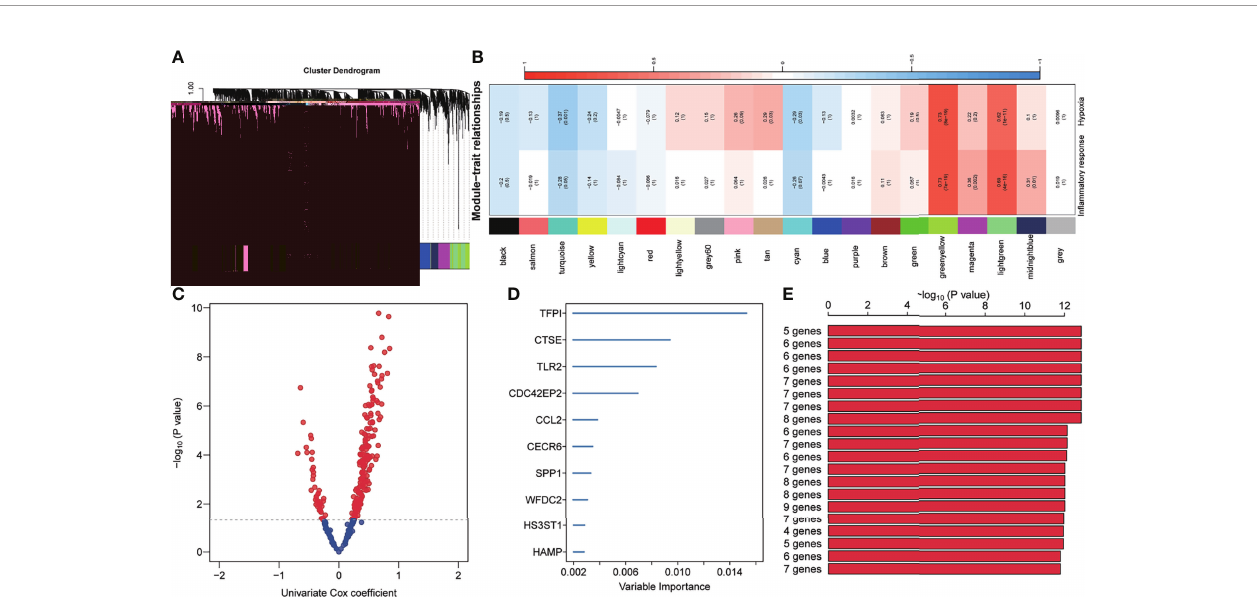
FIGURE 2 | Development of in fl ammation response and hypoxia-related gene signature. (A) Cluster dendrogram and co-expression modules were identi fi ed using Weighted Gene Co-expression Network Analysis. Each colour represents one module. (B) Correlation analysis between the gene module and in fl ammatory response and hypoxia-related gene signature. (C) The prognosis-related genes in the green-yellow and light-green modules were screened using univariate Cox regression. (D) The top 10 genes were identi fi ed using random survival forest algorithms. (E) The top 20 gene signatures were ranked by -log10 p-value on a Kaplan – Meier